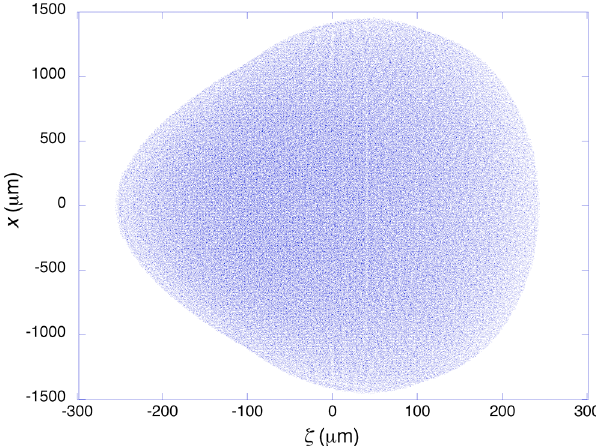
FIG. 3. Approximation of ellipsoidal distribution formed after 250 MV = m peak field rf photoinjector (downstream of photo- cathode z ¼ 1 . 5 m) in 125 pC blowout regime case.